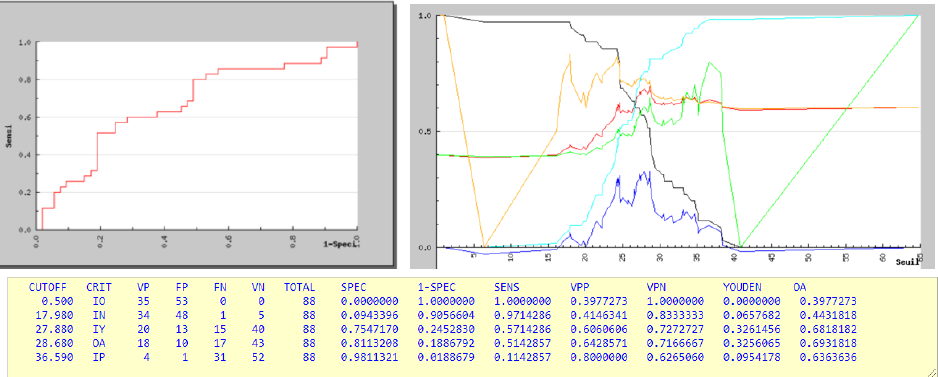
Figure 4. ROC Curves and Threshold Curves for initial date 1 Cobb Angle for Main Thoracic scoliosis. Black: sensibility; Blue: Youden Index; Red: OA; Green: Positive Predictive Value; Orange: Negative Predictive Value; Cyan: Specificity.